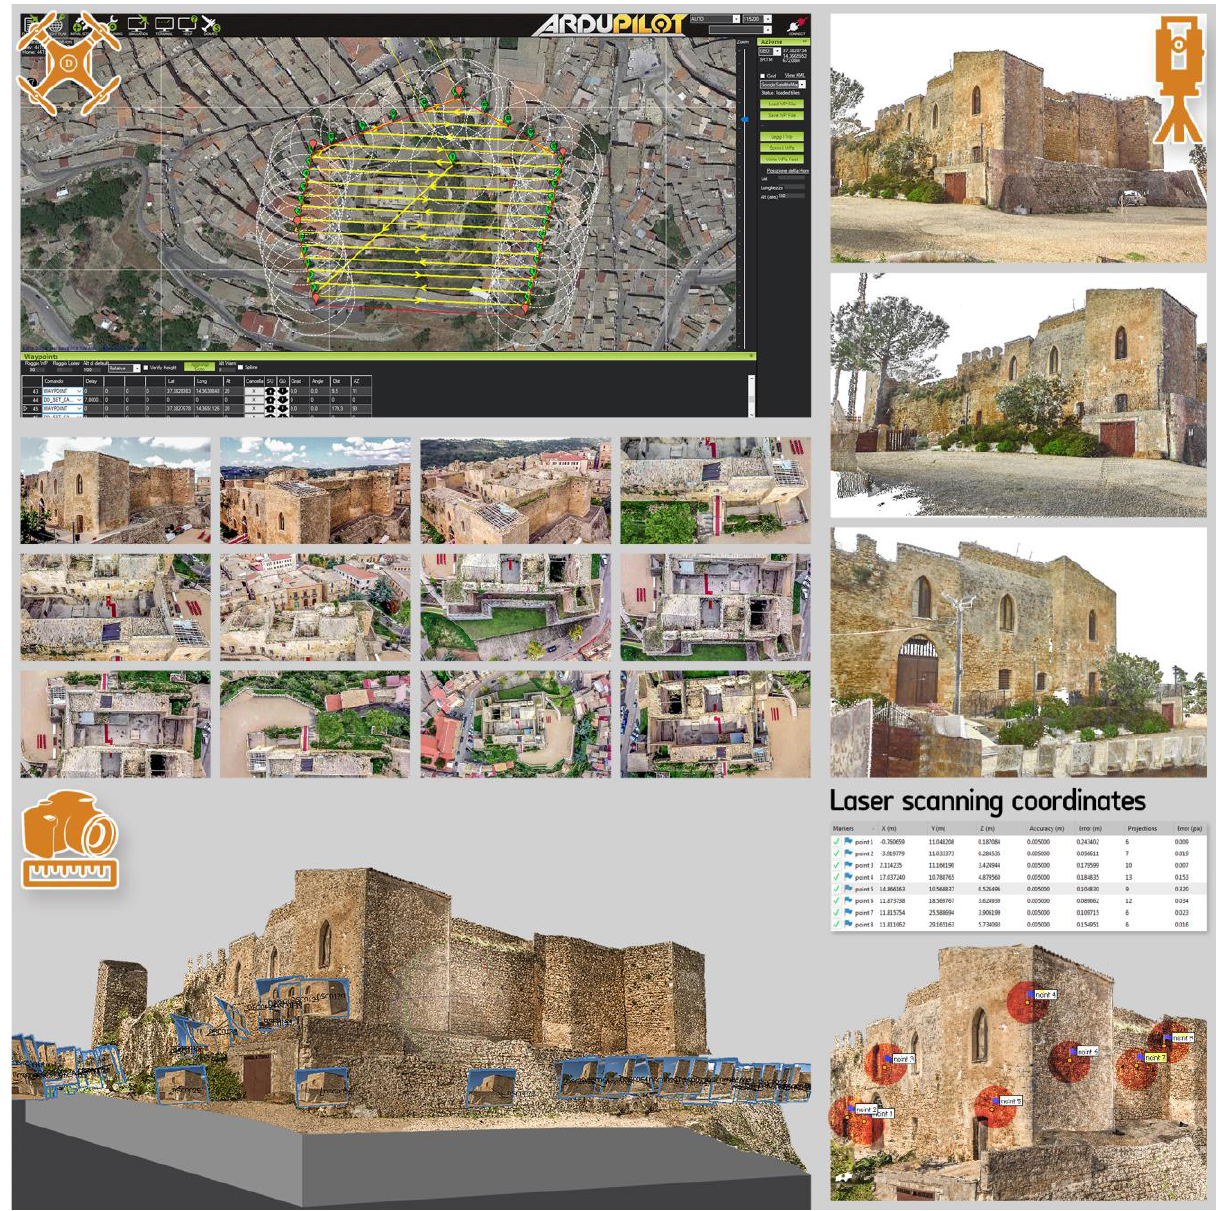
Figure 4. The castle of Piazza Armerina: integrated